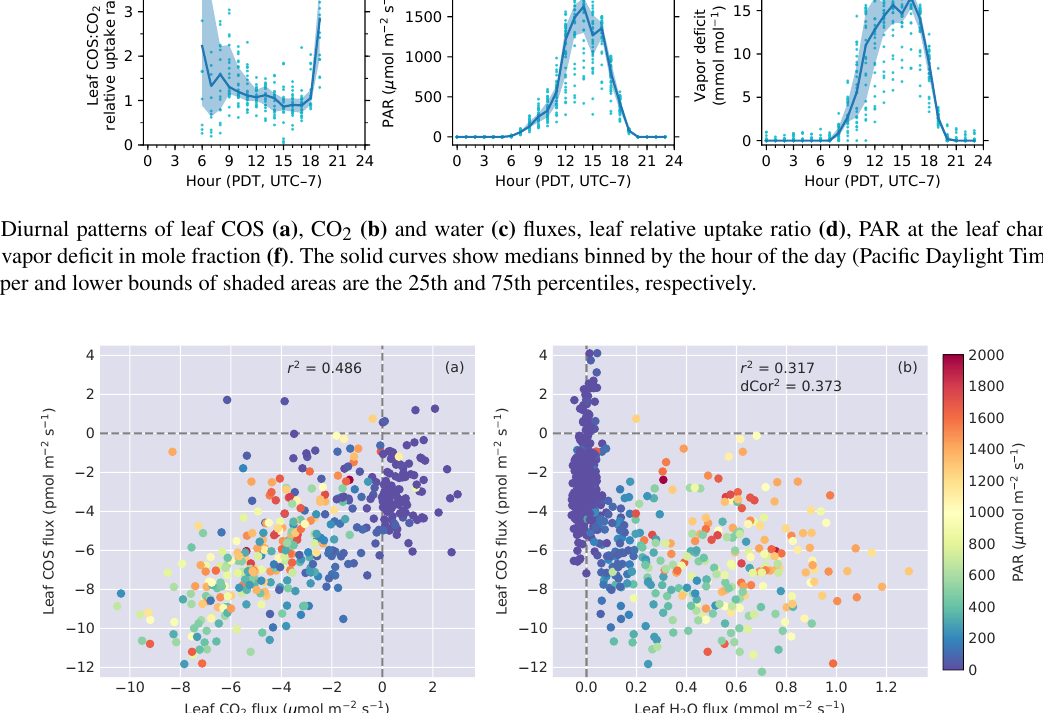
typical midday light level (1800 µmol m − 2 s − 1 ), COS uptake drops by 37 % from the peak value of 7.5 pmol m − 2 s −